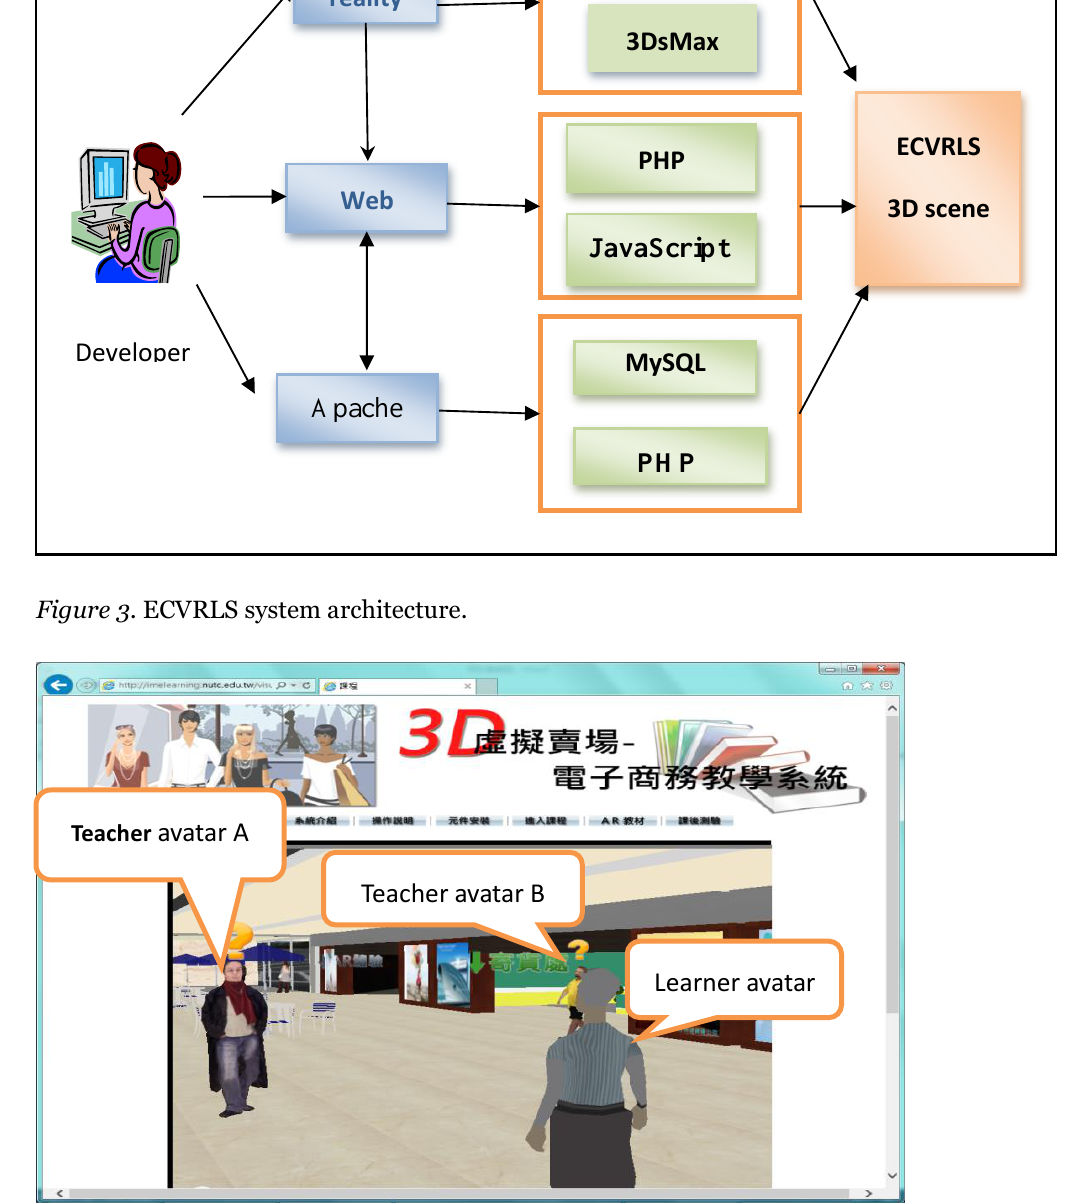
Figure 4. A virtual 3D shopping mall learning